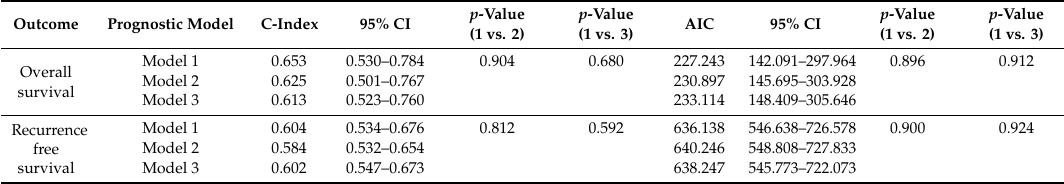
Table 5. Prognostic performance of models that included decreases and normalization of carbohydrate antigen 19-9 concentration after neoadjuvant chemotherapy and surgery on overall survival and recurrence free